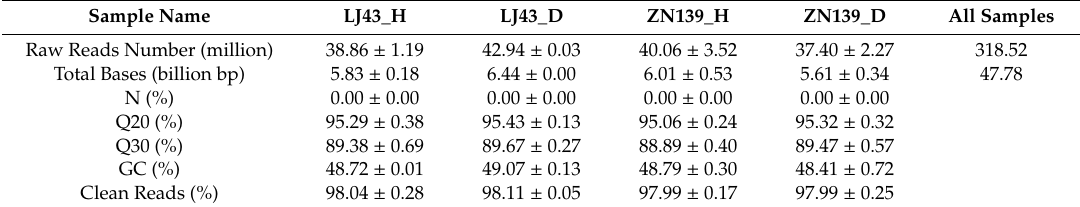
Table 1. Summary statistics of raw reads and clean reads.